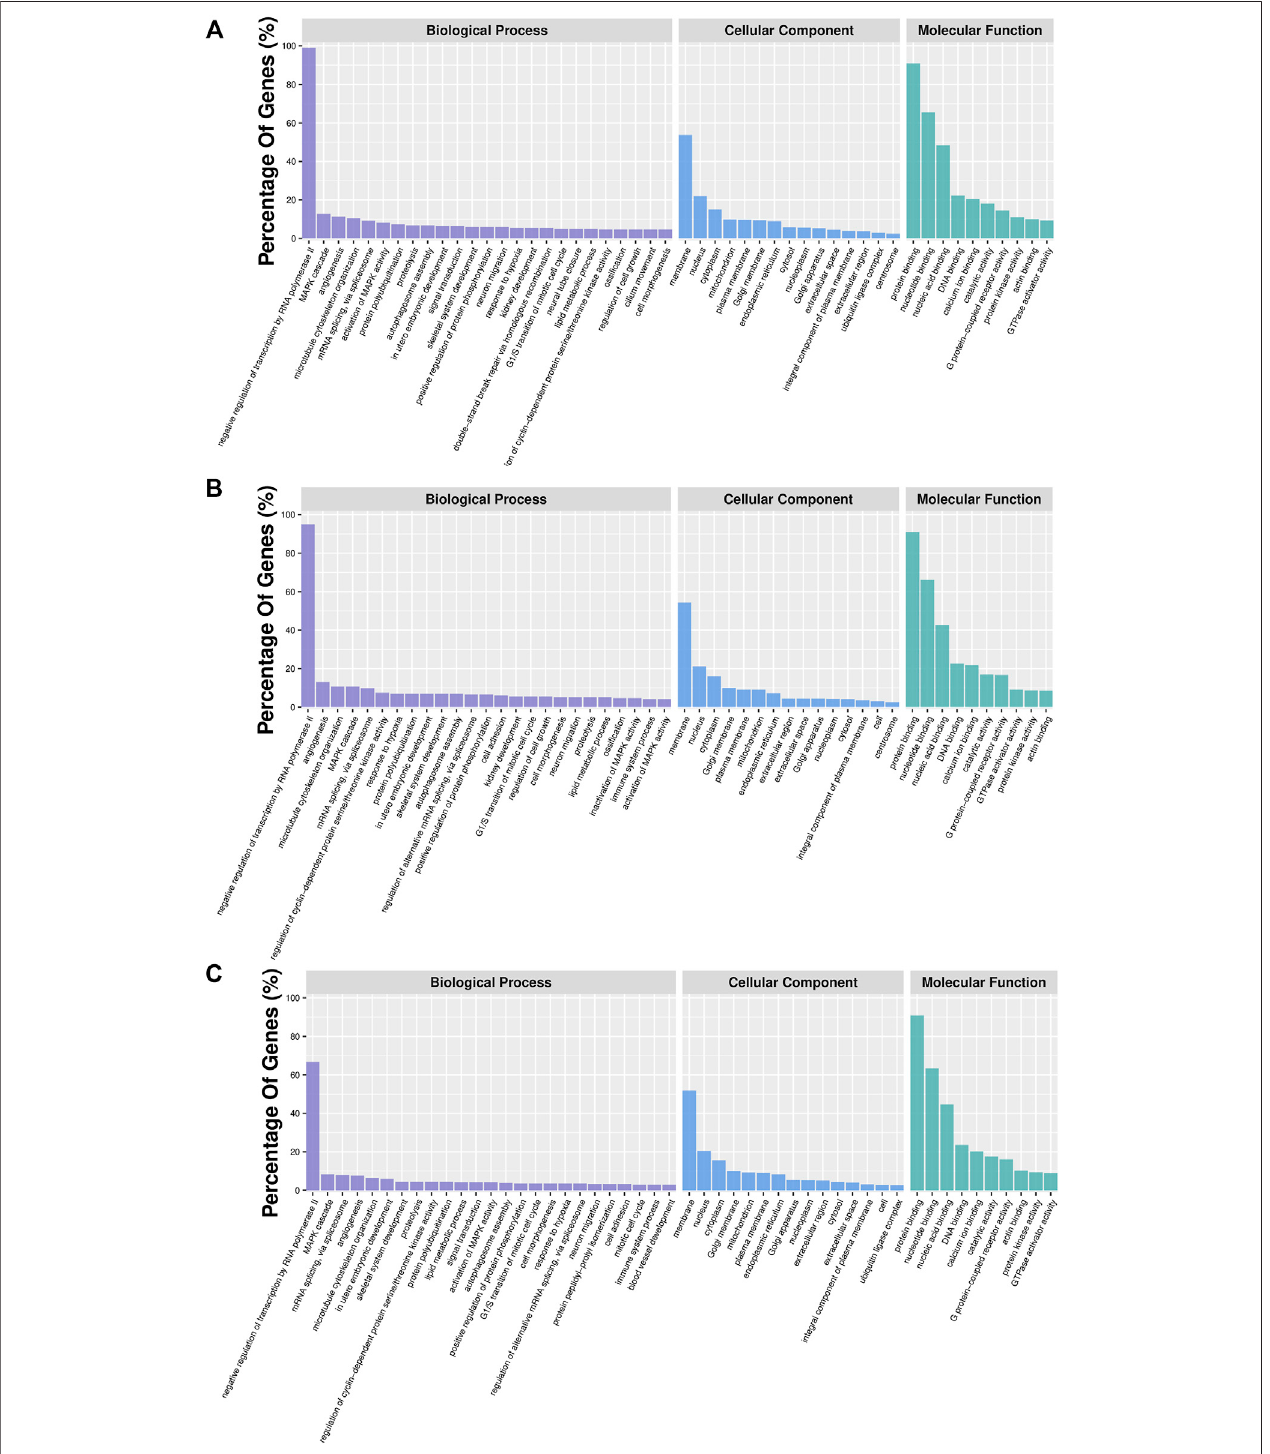
FIGURE 6| GO analyses ofDMGs located in the vicinity of signi fi cantdifferentially methylated regions (DMRs) ofthe IR vs. IC (A) , IS vs. IC (B) , and ISvs. IR groups (C) . Bar plots display enriched GO terms. The plots show signi fi cantly enriched degrees ( p < 0.05).